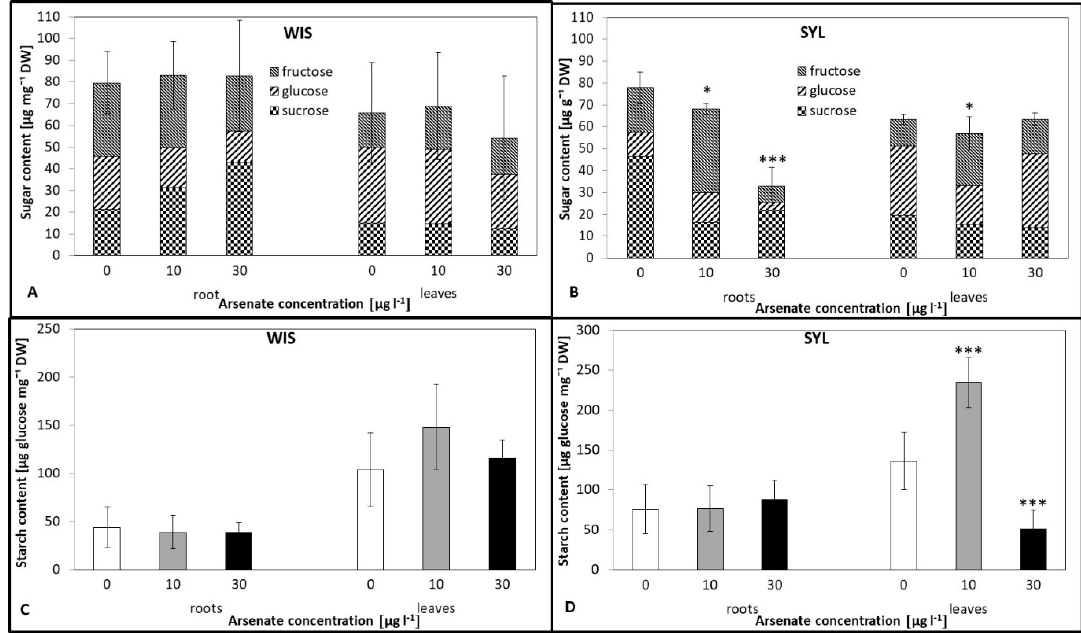
Figure 6. Effects of arsenic on soluble carbohydrate ( A, B ) and starch ( C, D ) contents in two Figure 6. E ff ects of arsenic on soluble carbohydrate ( A , B ) and starch ( C , D ) contents in two contrasting contrasting tobacco genotypes (A, C tolerant N.tabacum cv. Wisconsin; B, D sensitive N. sylvestris ; C, tobacco genotypes ( A , C ) tolerant N.tabacum cv. Wisconsin; ( B , D ) sensitive N. sylvestris ; ( C , D ) amount D amount of glucose after enzymatic starch degradation). 0, 10, and 30 µg l -1 arsenic treatments. Bars of glucose after enzymatic starch degradation). 0, 10, and 30 µ g l − 1 arsenic treatments. Bars indicate indicate standard deviations. Stars mean statistically significant differences from control at the level standard deviations. Stars mean statistically significant di ff erences from control at the level α = 0.1 ((*)), α = 0.1 ((*)), 0.05(*), 0.01 (**), or 0.001(***), n = 10. 0.05(*), 0.01 (**), or 0.001(***), n =